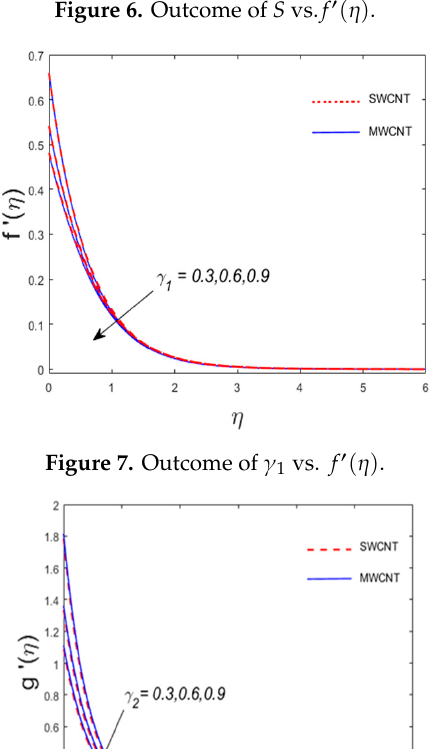
Figure 8. Outcome of γ 2 vs. g (cid:48) ( η )